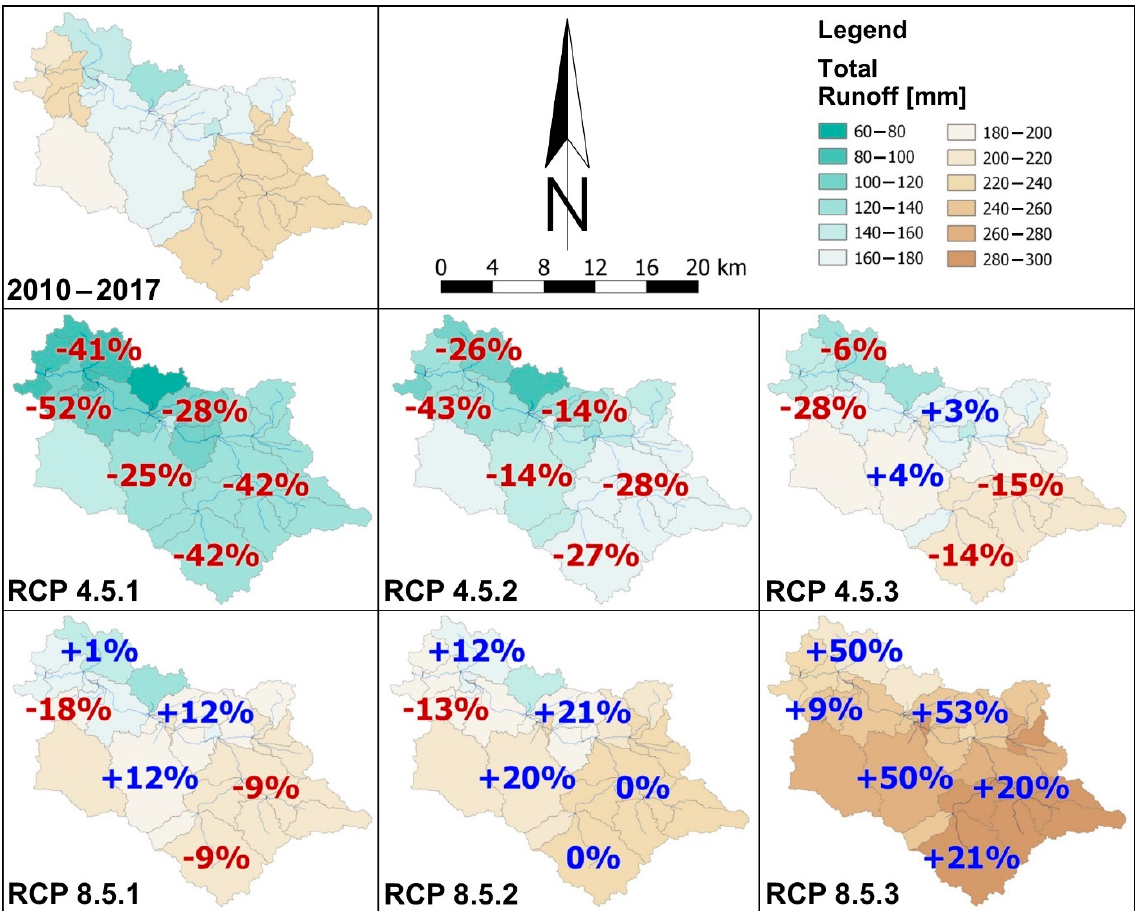
Figure 15. Comparison of the average annual sums of surface runoff in 31 sub-catchments for the SWAT simulation period 2010–2017 and 2041–2050 for individual climate projections in the RCP 4.5 and RCP 8.5 scenarios (own study).